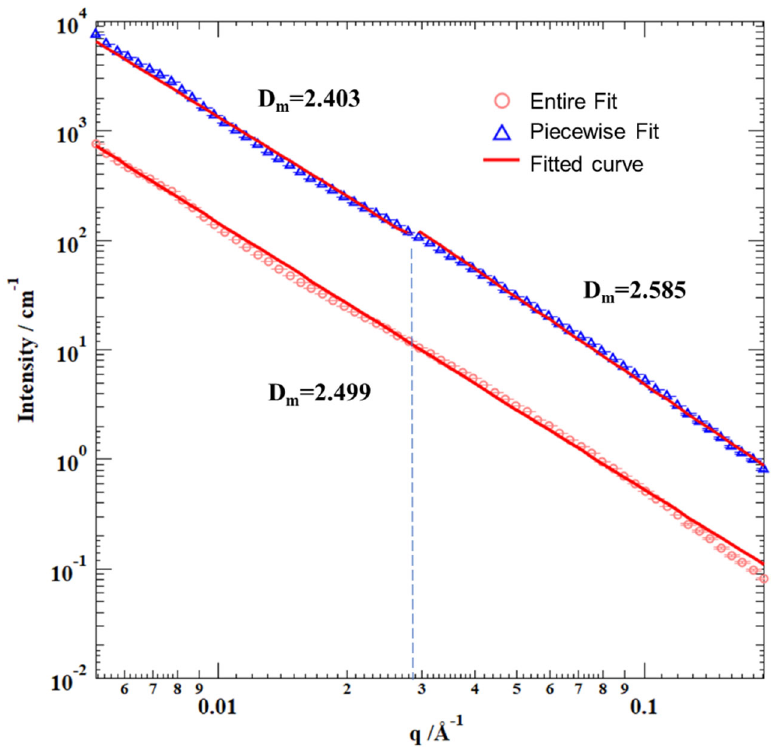
Figure 18. L7 sample scattering intensity curve